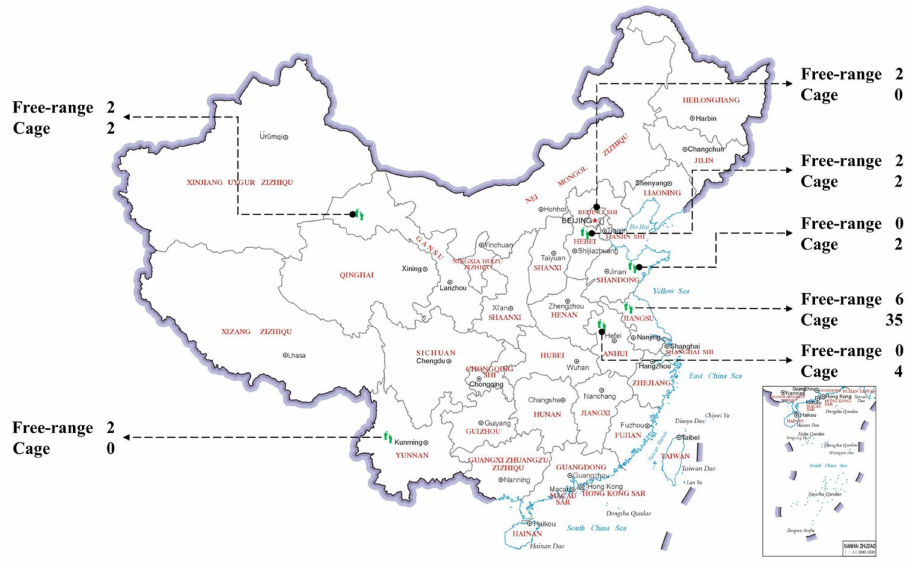
Figure 1. Distribution of participating egg production